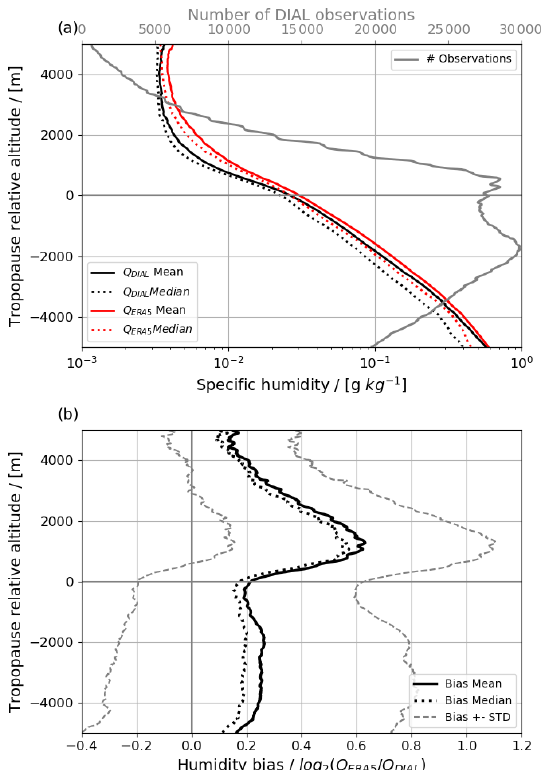
Figure 5. Tropopause-relative (a) vertical profiles of the DIAL (black lines) and the ERA5 (red lines) mean (solid) and median (dotted) specific humidity and the number of observations (grey). Note the log-scale notation of the x axis. (b) Mean/median bias (solid/dotted lines) and standard deviation (dotted grey lines).